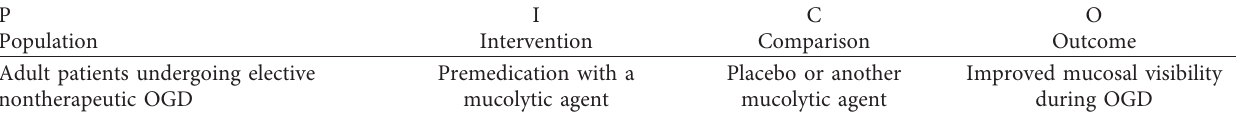
Table 1: PICO model used to define search criteria for the search strategy to be used in the relevant bibliographic databases.